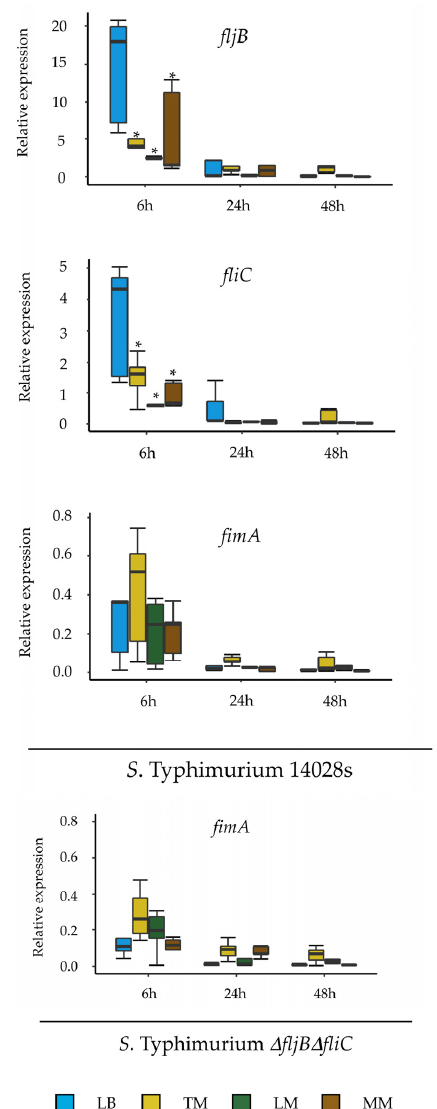
Figure 3. Flagellin expression is reduced in plant-based media. Expression of the flagellin fljB , fliC and the adhesin fimA genes was assessed 6, 24 and 48 h after inoculation of S. Typhimurium 14028s into plant-based (LM or TM) media. Inoculations into LB and minimal media (MM) were used as controls. The expression of fimA was assessed additionally in the Δ fljB Δ fliC mutant. The amount of mRNA was normalized to the expression level of Salmonella rfaH . Asterisks indicate p ≤ 0.05 in Tukey HSD test. For more information about significant differences among treatments, please see Supplementary Table S3. The fimA gene encoding for type 1 fimbriae (major subunit) was used as a control. Fimbriae play a role in mediating Salmonella adherence to eukaryotic cells [40]. In contrast, expression levels of the control gene fimA at 6 hpi were very similar in all media for both strains. At later time points, expression of fljB , fliC and fimA genes was significantly reduced (Figure 3).